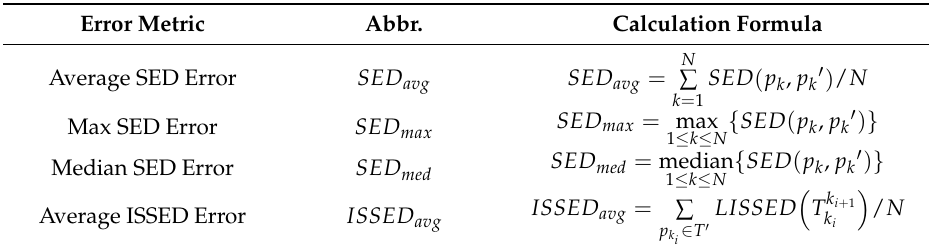
Table 4. Abbreviation and calculation formula of different error